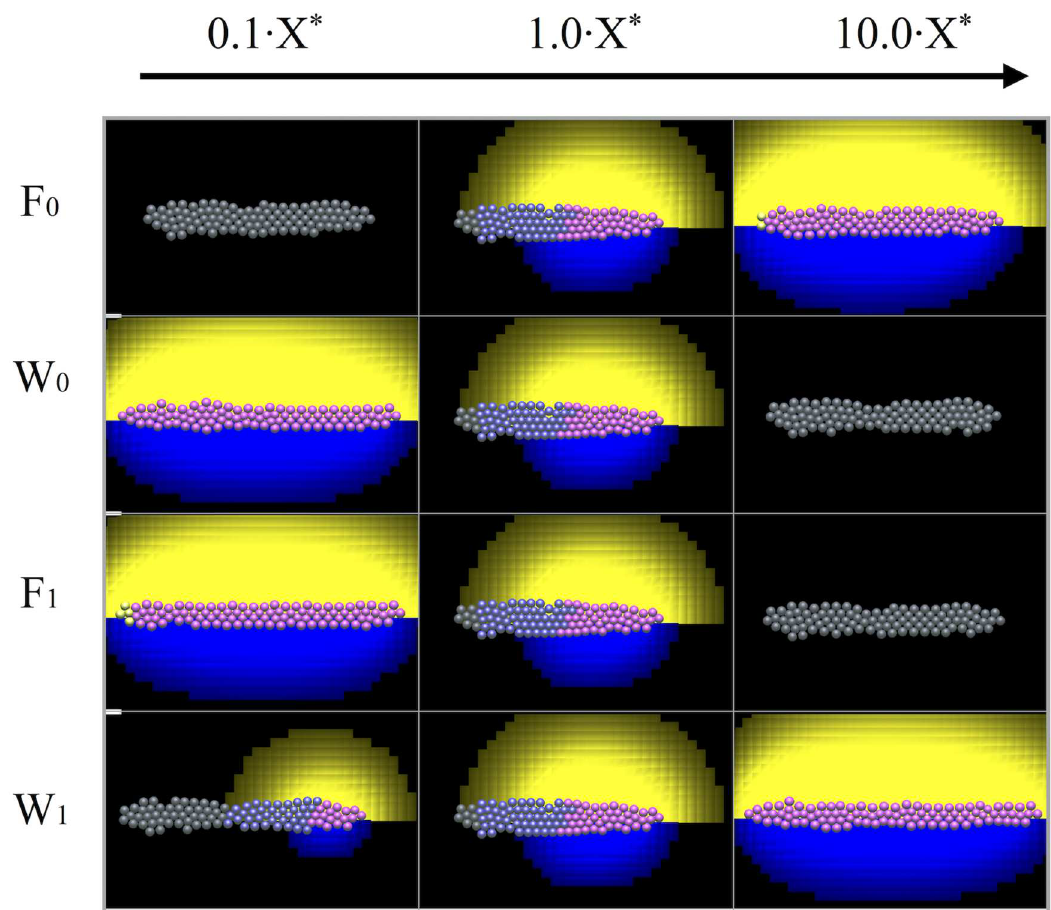
Fig 8. The position of the boundary between the leading and trailing zones is parameter dependent. The four parameters, F 0 , F 1 , W 0 and W 1 are altered. In the first column the baselinevalue ( X * ) has been multipliedby 0.1 and in the last column it has been multiplied by 10. Increasing F 0 (top row) and W 1 (bottom row) results in an increasein the size of the Wnt domain.Conversely,increasing F 1 (second row) and W 0 (third row) results in a decreasein the size of the Wnt domain.Results from the full 3D model after 50 min of simulationtime (before the onset of migration).